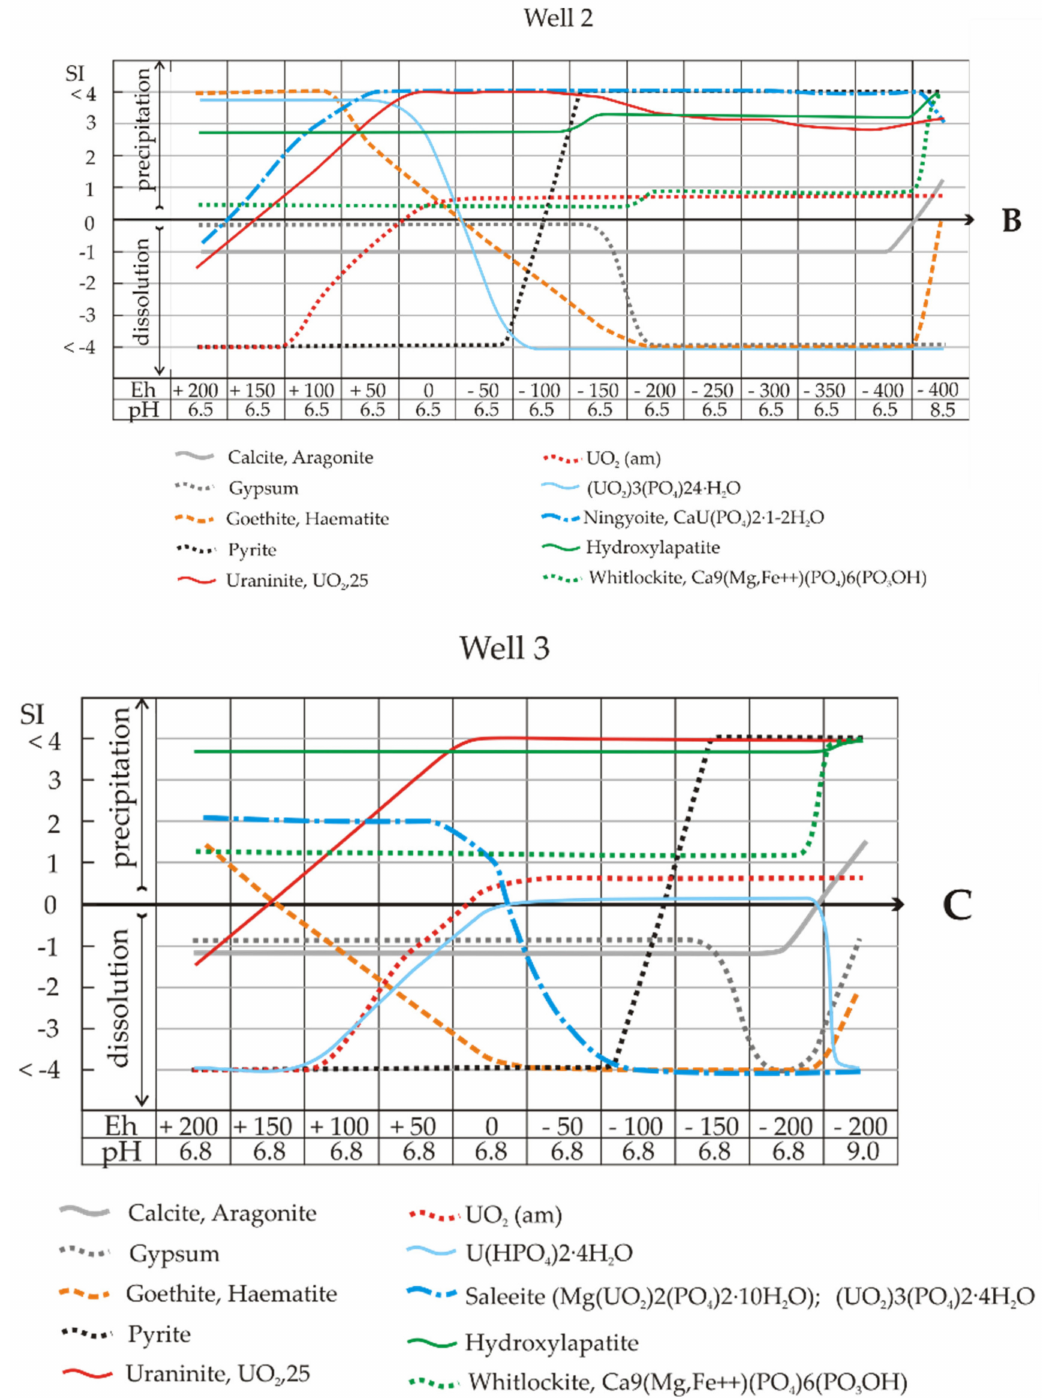
Figure 7. Thermodynamic model calculations of the saturation indexes (SIs) of water from Sample 1 ( A ), Sample 2 ( B ), and Sample 3 ( C ) after biostimulation with whey. Points indicated with * and ** correspond to the values obtained without fixed pH in conditions of organic matter oxidation to CO